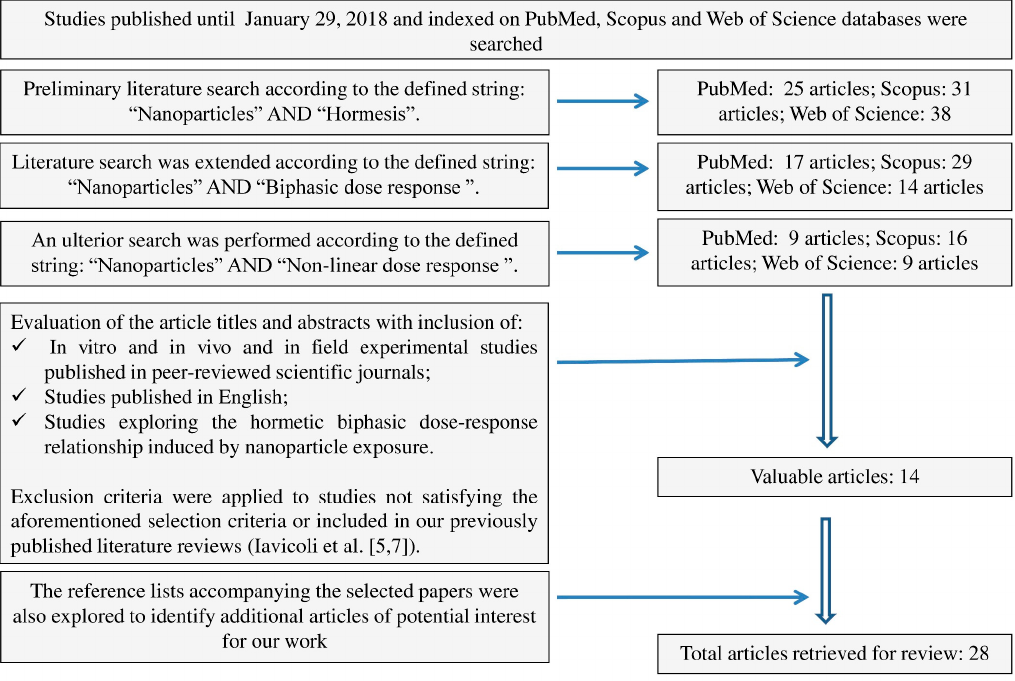
Figure 6. Flow diagram of literature